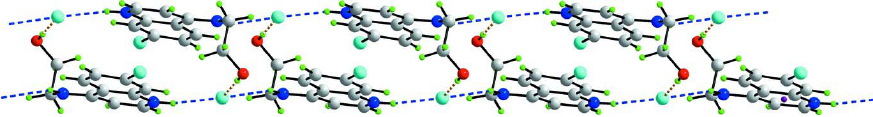
Figure 1 The molecular structures of the ions in (I) showing the atom-labelling scheme and displacement ellipsoids at the 70% probability level.